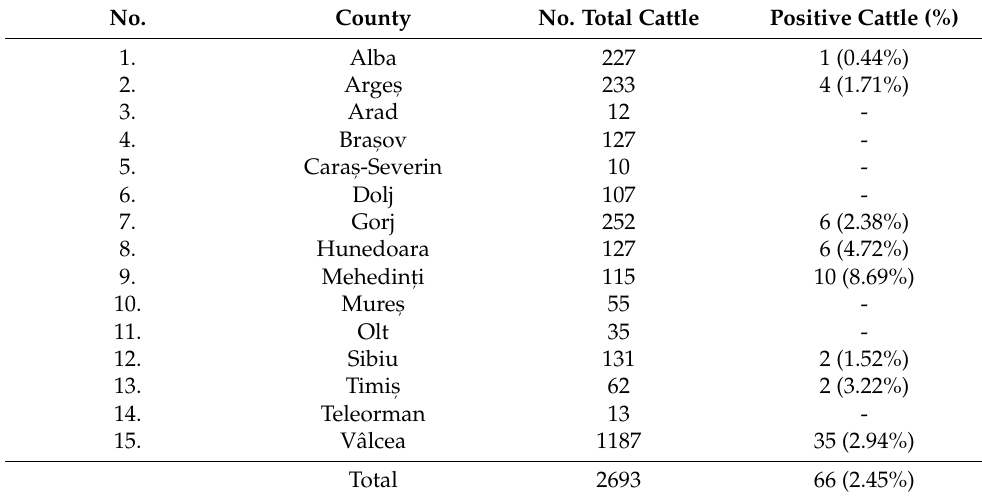
Table 1. The prevalence of cystic echinococcosis in different investigated counties of Romania.